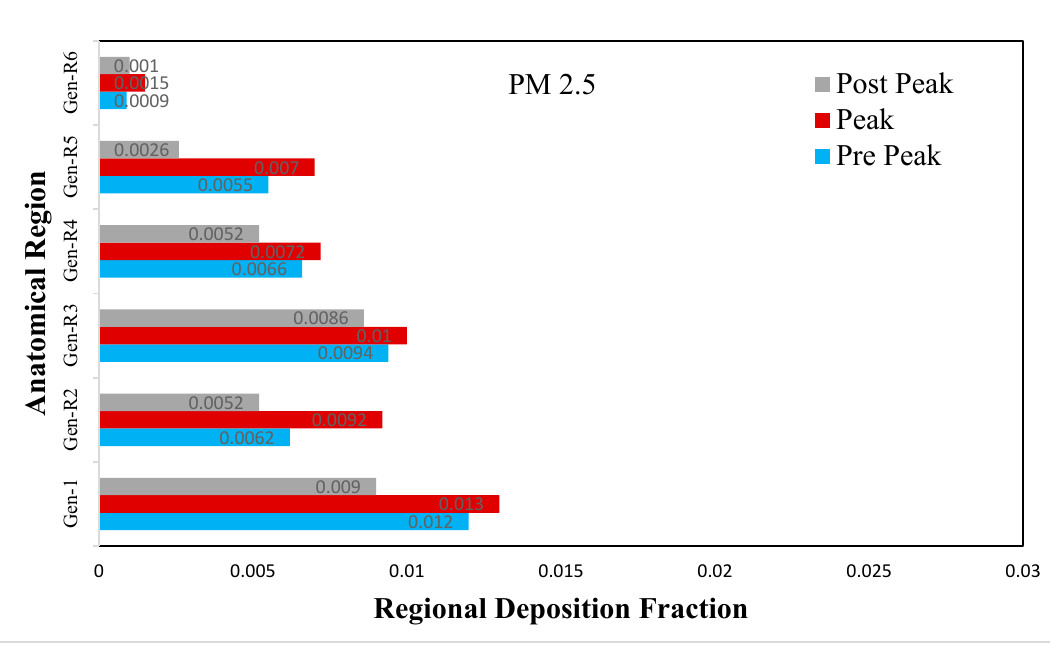
(a) ( i ) Right bronchial tree